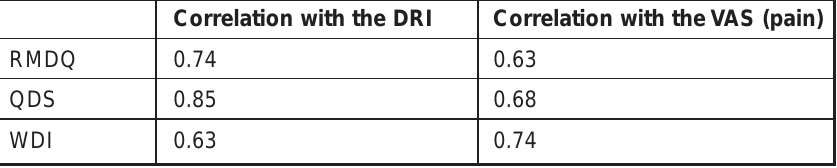
Table 2: Pearson correlation coefficient of the Tswana versions of RMDQ, QDS and WDI with the DRI and VAS (pain) Correlation with the